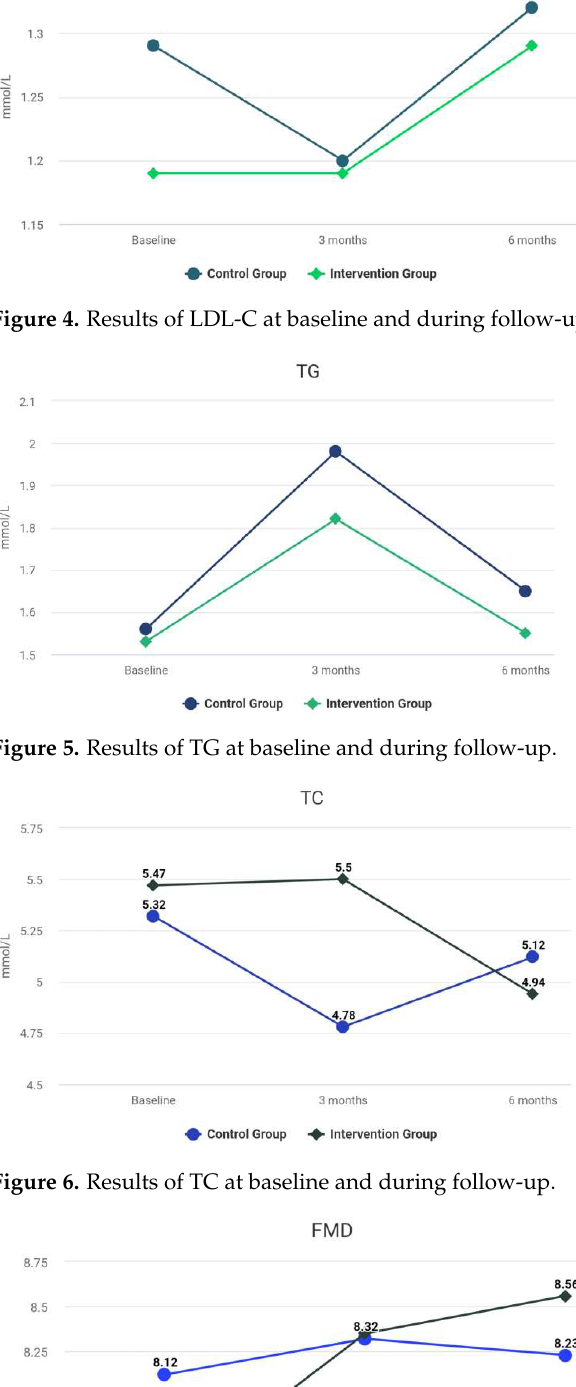
Figure 2. Results of HDL-C at baseline and during follow-up.